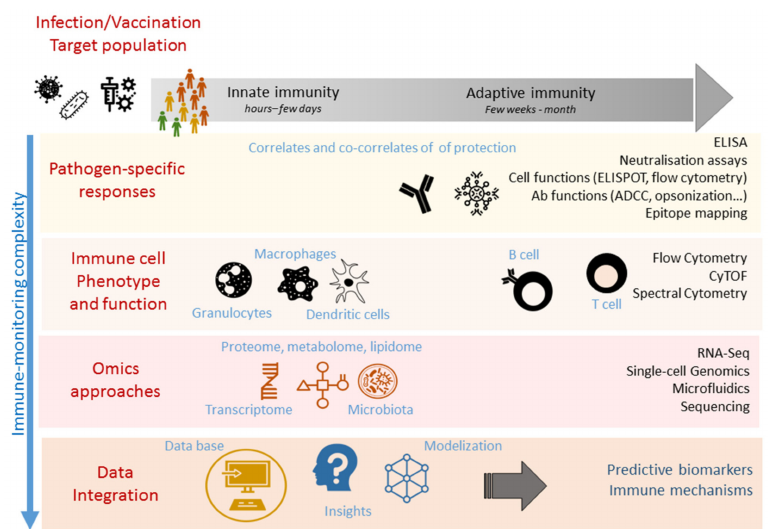
Figure 1. Immunomonitoring techniques for vaccination. Immunomonitoring of innate and adaptive immune responses is based on a collection of biological samples, either freshly collected or cry- oconserved, which have been ob-tained after infection or vaccination. Various immunomonitoring approaches are summarized, from easy-to use methods such as ELISA or ELISpot, to more complex methods such as CyTOF, spectral cytometry or RNA-seq that depict more precise fea-tures of the immune responses. However, these methods require skill in informatics and